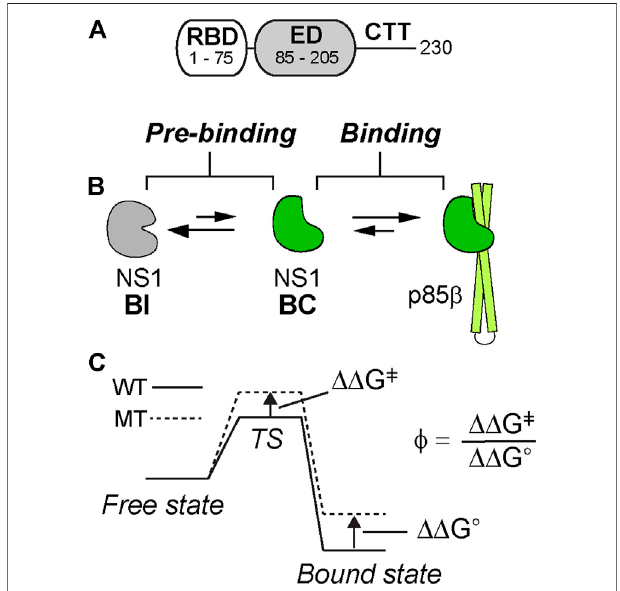
FIGURE 1 | (A) Domain organization of 1918 NS1 (B) Binding scheme between 1918 NS1 and p85 β . BI and BC represent binding-incompetent and – competent states, respectively (C) Diagram showing graphical de fi nitions of ΔΔ G ° , ΔΔ G ǂ , and ϕ